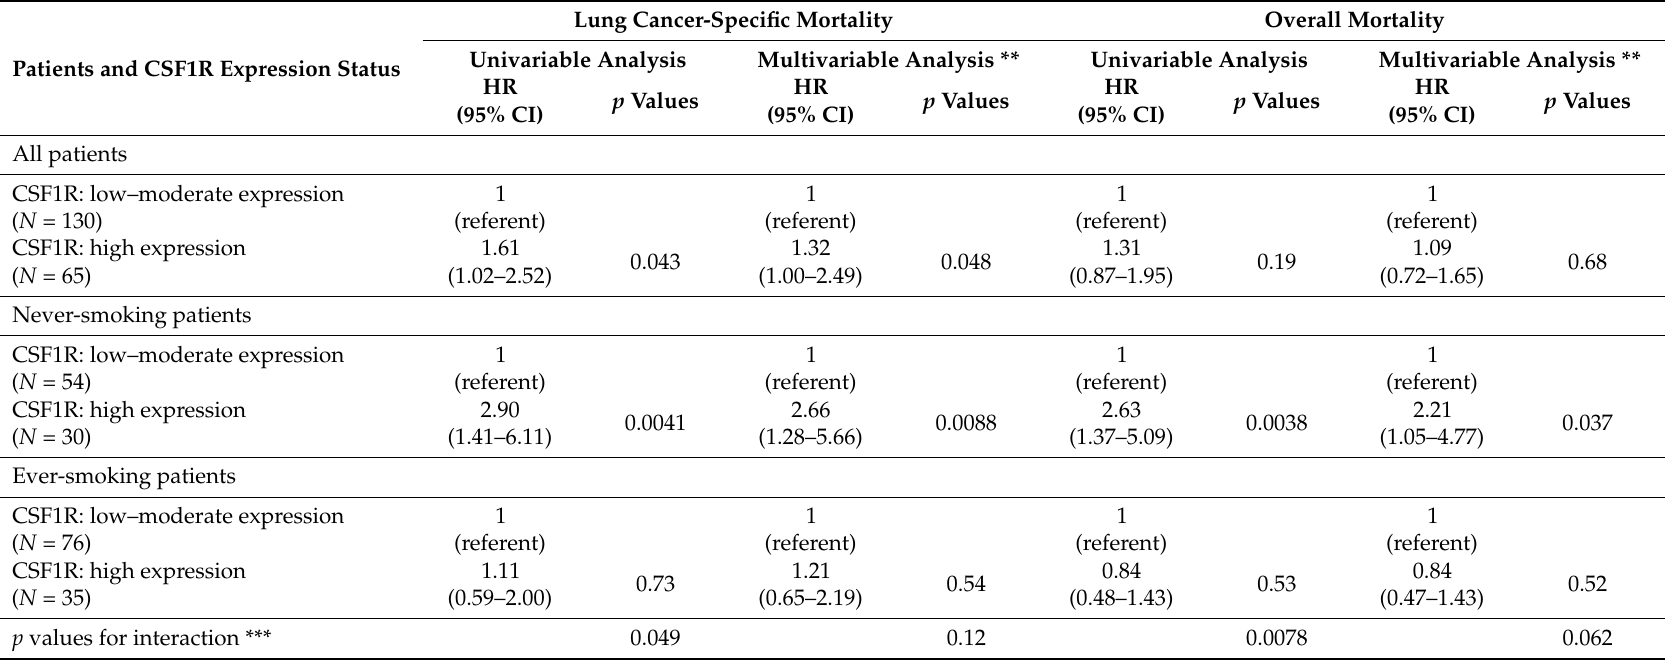
Table 2. CSF1R expression in tumor-associated macrophages and patient mortality * in lung adenocarcinoma, stratified by smoking status.